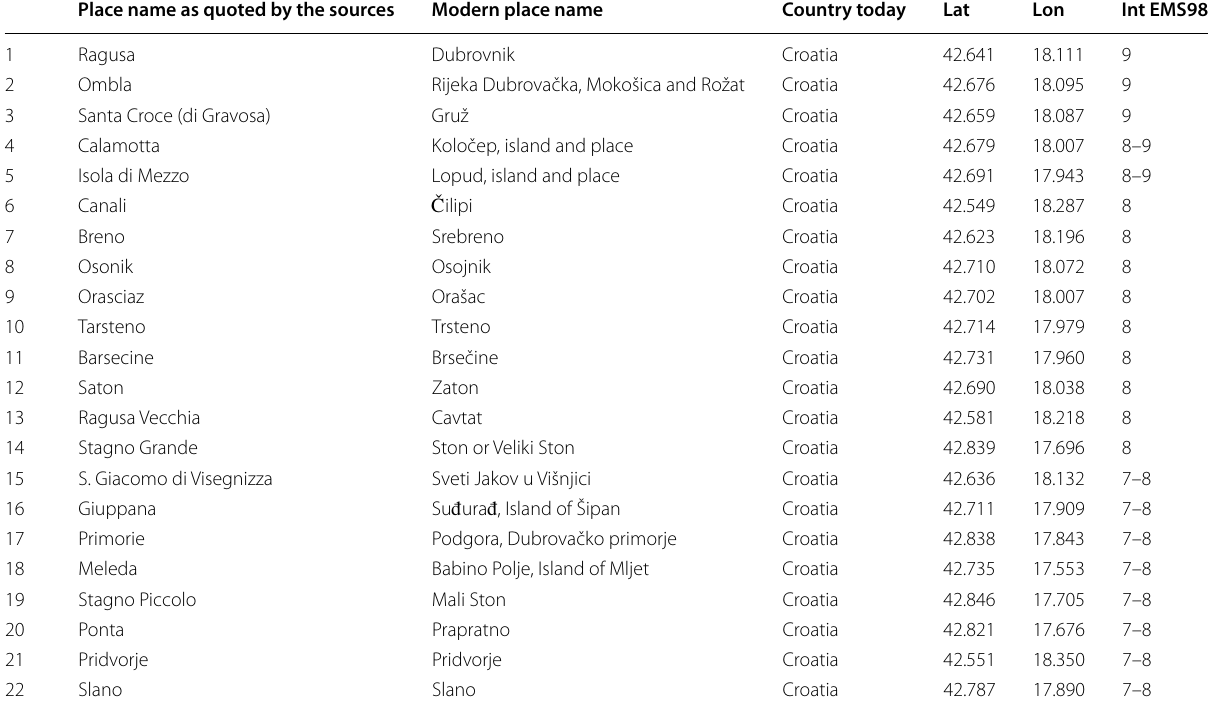
Table 3 Affected places in the Republic of Ragusa Place name as quoted by the sources